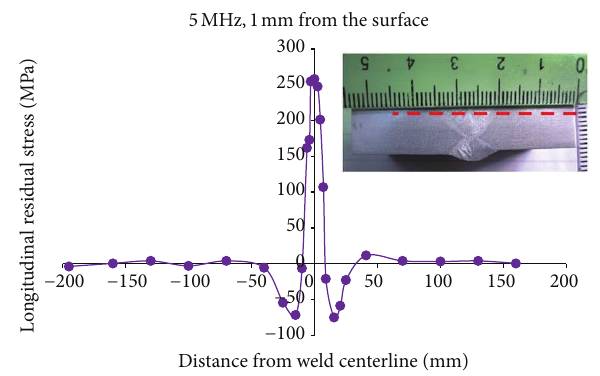
Figure 11: Ultrasonic stress measurement results by 5MHz L CR